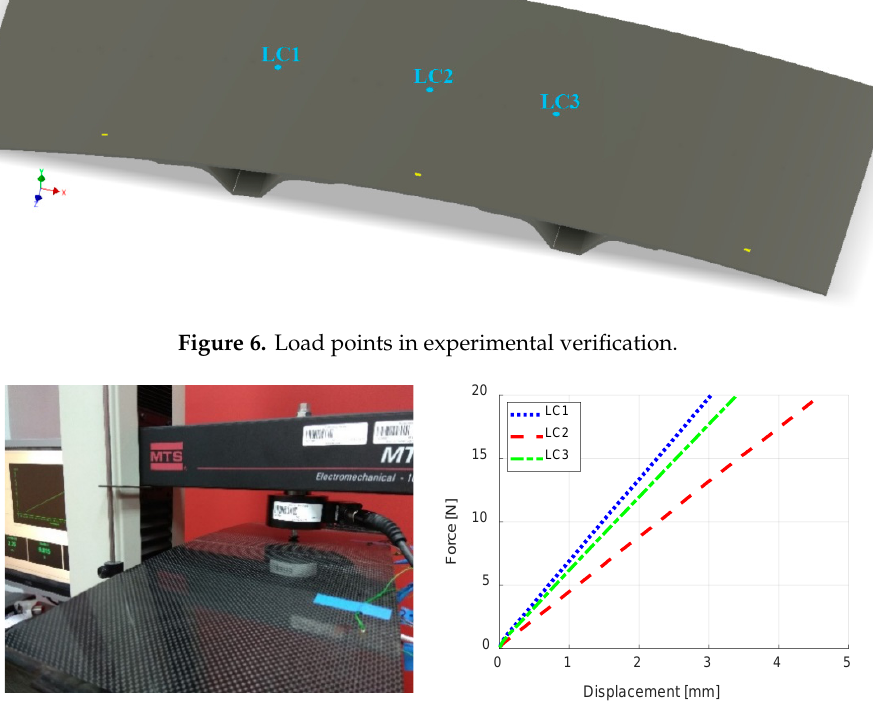
Figure 7. Experimental verification of the accuracy of numerical model: ( a ) photograph from the experiment and ( b ) force–displacement plots. Table 4. Comparison of numerical and experimental stiffnesses of the composite panel.